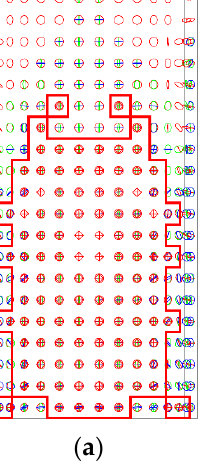
Figure 10. Crushing diagram of the cover concrete ( a ) PMR; ( b ) CIPM; ( c ) TPM.